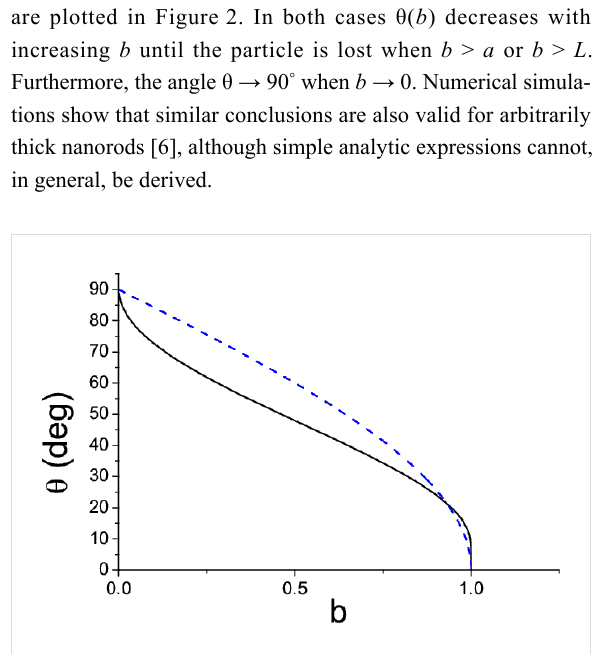
Figure 2: Angle of motion θ of a nanosphere (solid curve) and a nanowire (dashed curve) as a function of the distance b between consecutive scan lines. The parameter b is expressed in units of the sphere radius a and wire length L